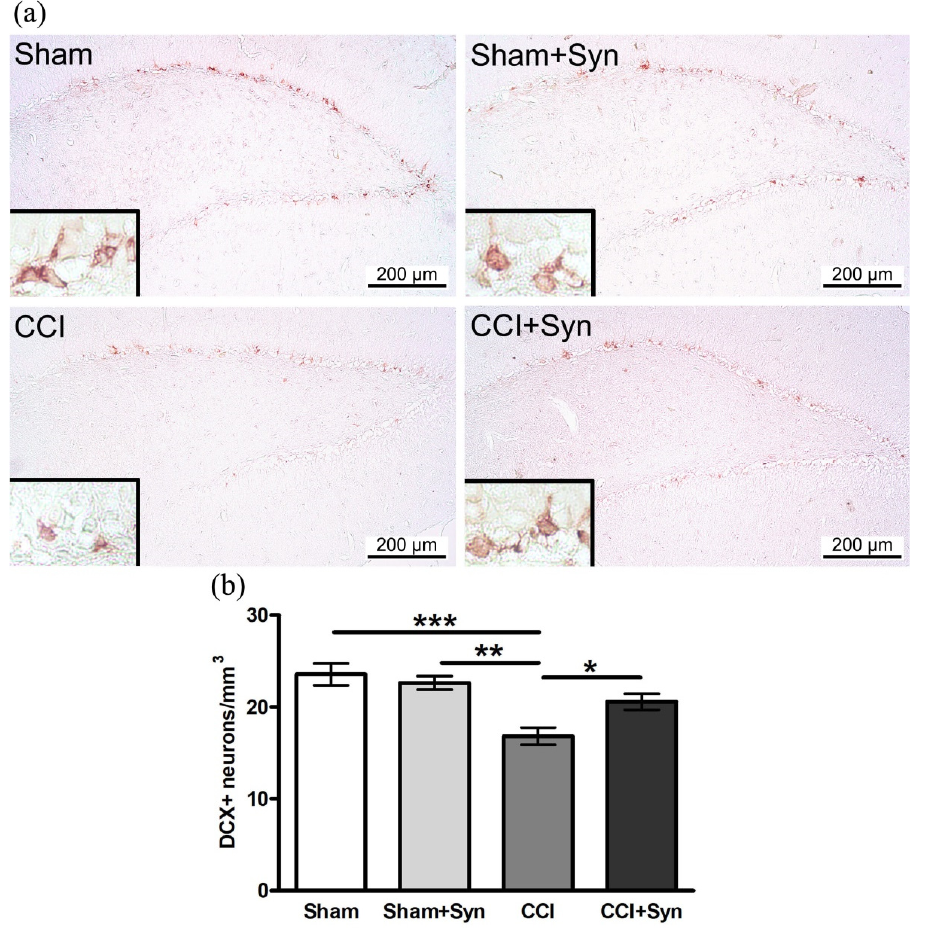
Figure 3. Effect of CCI and synaptamide treatment on hippocampal neurogenesis. ( a ) Representative images of DCX-positive staining. ( b ) Histogram showing the changes in the number of immature neurons (by DCX) in the DG SGZ. Data are presented as mean ± SEM, n = 7/group, * p < 0.05, ** p < 0.01 and *** p < 0.001 (one-way ANOVA, post-test Tukey).